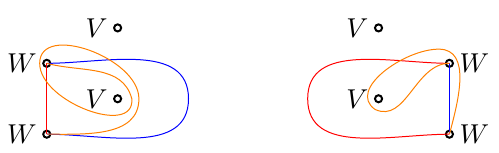
Figure 2 . Different channels corresponding to paths along which the pair of W operators can be contracted. The colours denote channels that should be identified across the two diagrams if the W operators are moved horizontally to the right. However, if the W operators where moved below the V operators the red path in the left diagram would be identified with the blue path in the right diagram. This leads to the branch cut in the conformal